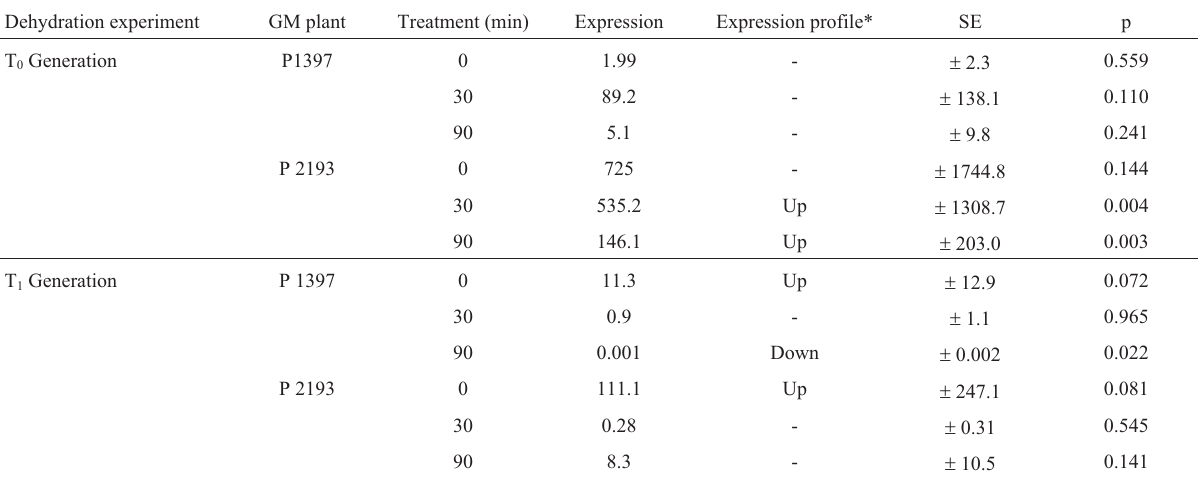
Table 2 - Relative expression of the AtDREB2A transgene in GM plants P1397 and P2193 in response to dehydration. Dehydration experiment